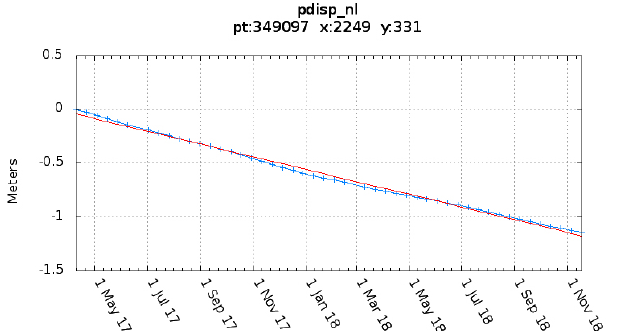
Figure 3. Displacement time series at the subsidence center of the Nanhu mining area.